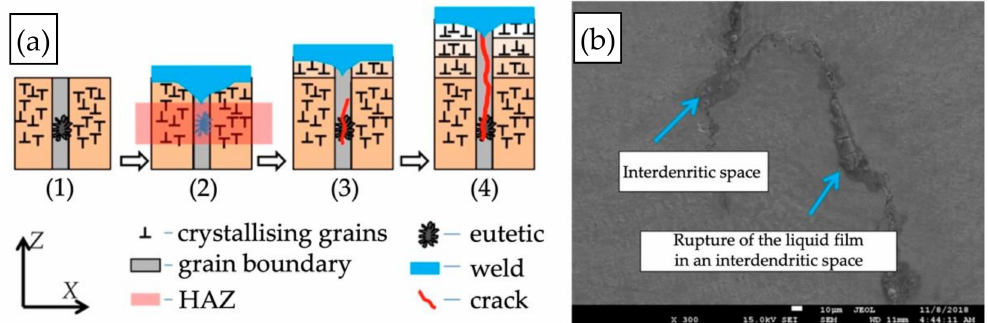
Figure 5. Liquation cracking mechanism: ( a ) diagram; ( b ) liquation cracks between dendrites [6].